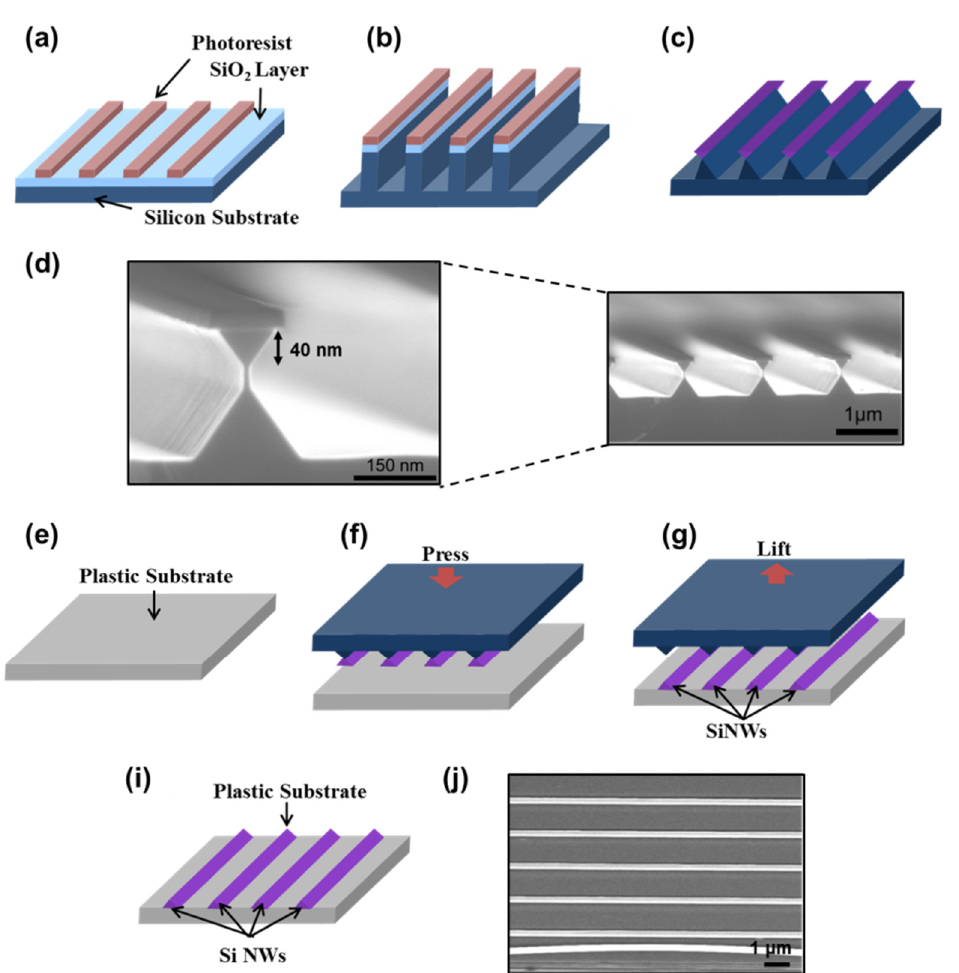
Figure 2. Fabrication process of the SiNWs. ( a ) Si active lines on an oxide stack. ( b ) Si trench etching. ( c ) Crystallographic wet etching. ( d ) SEM images of fabricated SiNWs. ( e – i ) transfer process of SiNWs on plastic substrate. ( j ) SEM image of transferred SiNWs.